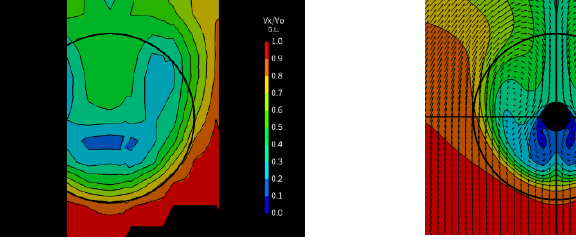
Figure 14. Comparison of results of the wake distribution of KVLCC2. (( Left ): EFD, ( Center ): k -omega SST, ( Right ): LPST).